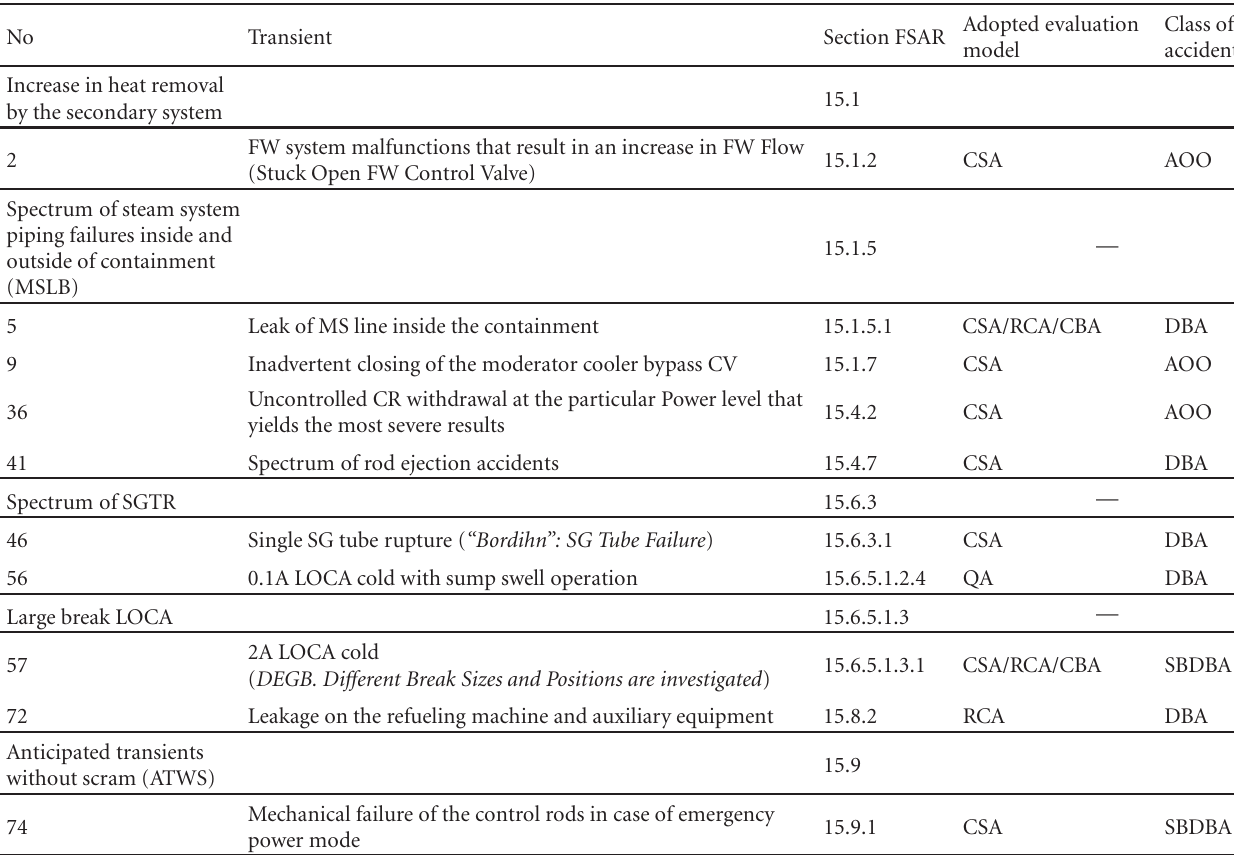
Table 2: Excerpt from the list of PIE for Atucha II Chapter 15 of